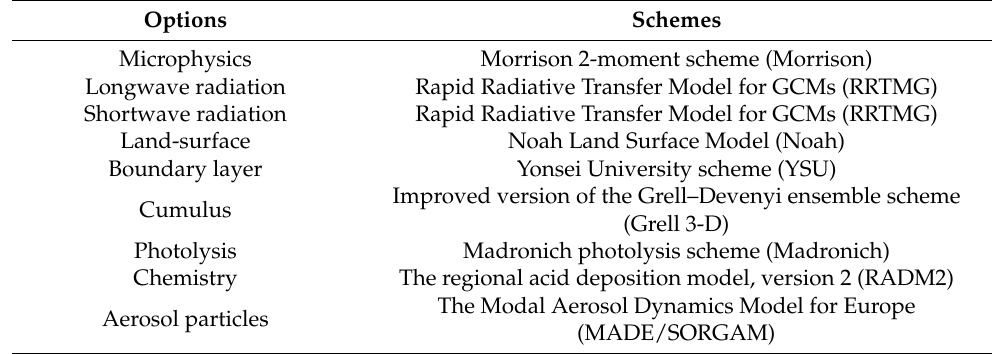
Table 1. Parameterization schemes for the WRF-Chem simulation.